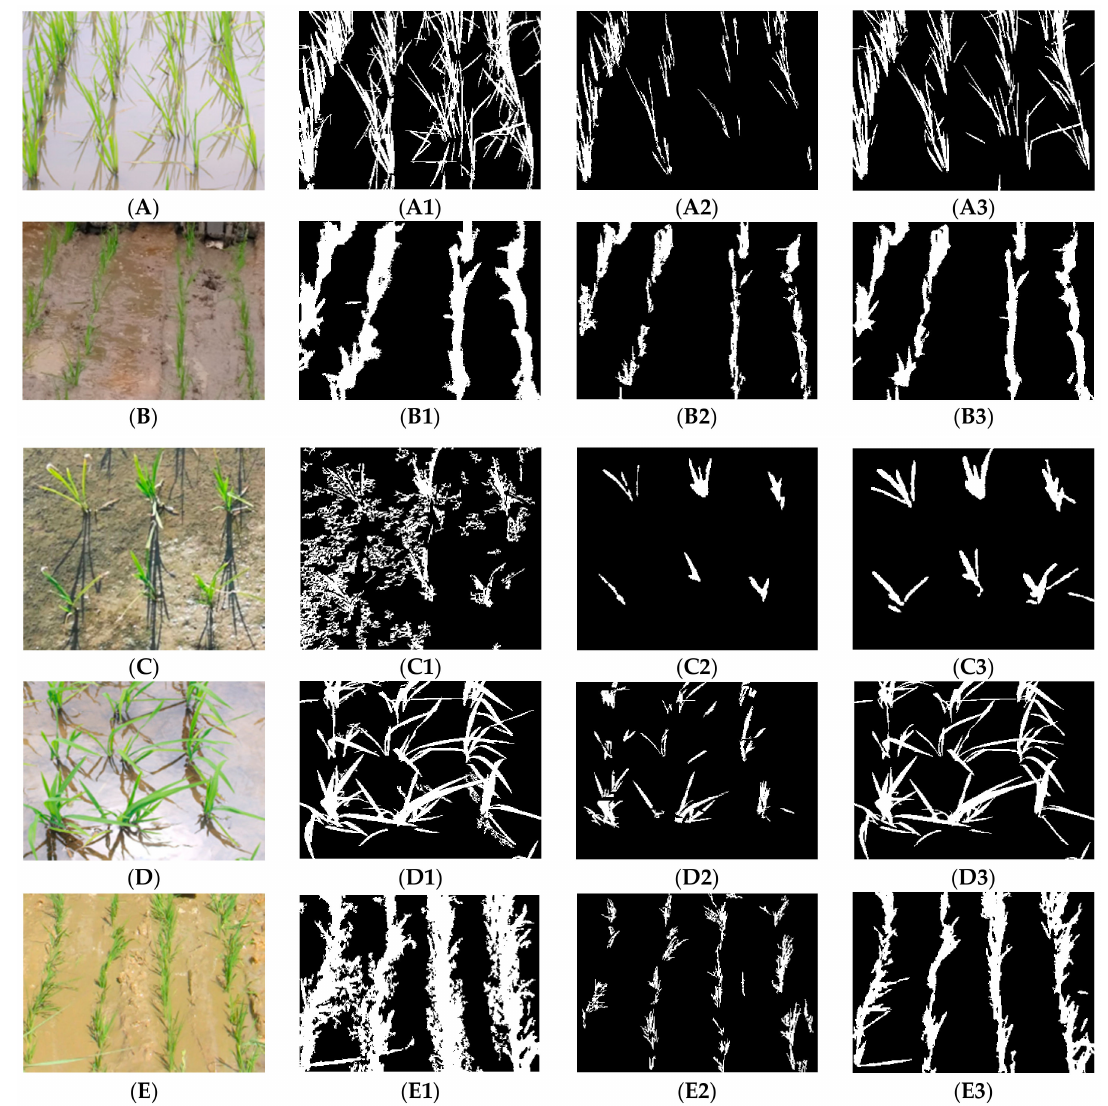
Figure 11. Segmentation results of the five test images by the proposed method and two other methods. ( A – E ) are the original rice seedling images; ( A1 – E1 ) show segmentation results by Otsu; ( A2 – E2 )